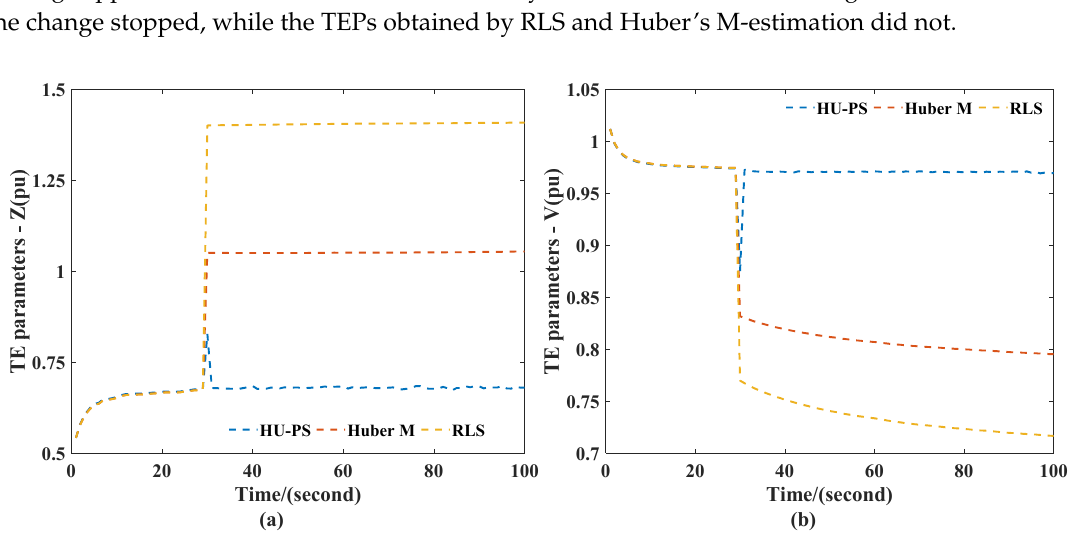
Figure 3. TEPs obtained in case I scenario 1: ( a ) impedance, ( b ) voltage.